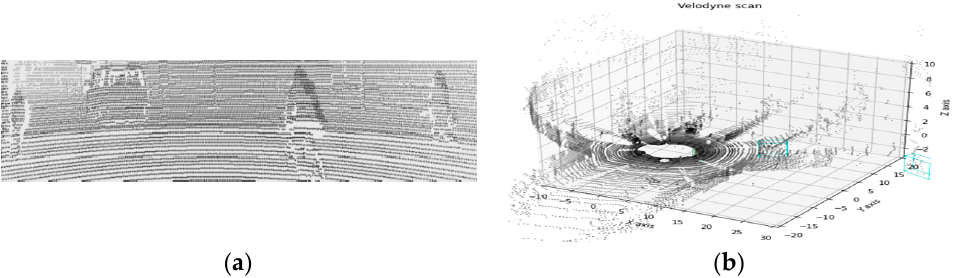
point cloud projection.